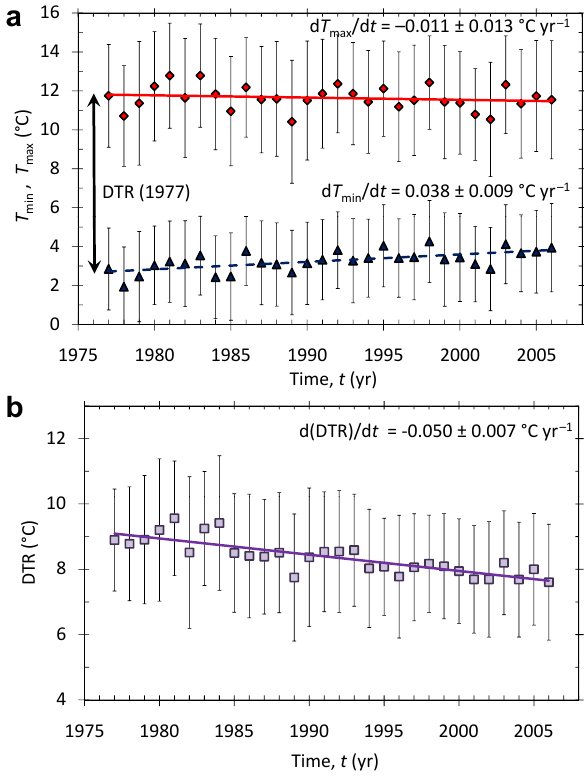
Fig. 5. Annual mean maximum temperatures ( T max ), minimum temperatures ( T min ), and diurnal temperature ranges (DTR), for 1977–2006, based on hourly Mauna Loa Observatory, Hawaii data (NOAA, 2009). (a) The sequence of annual mean maximum tem- peratures T max (diamonds) and minimum temperatures T min (tri- angles) are given as a function of time t for 1977–2006 (error bars ± 1s.d. of daily values for that year). The best-fit linear trends (solid and dashed lines) of the annual values are shown along with their slopes ( ± 1s.e. of the slope). An illustration of DTR= T max − T min for 1977 is also shown (vertical arrow). (b) The annual mean values of DTR (squares) are given as a function of time t ( ± 1s.d. of DTR values for that year). The best-fit linear trend (solid line) of the annual values is shown along with its slope ( ± 1s.e. of the